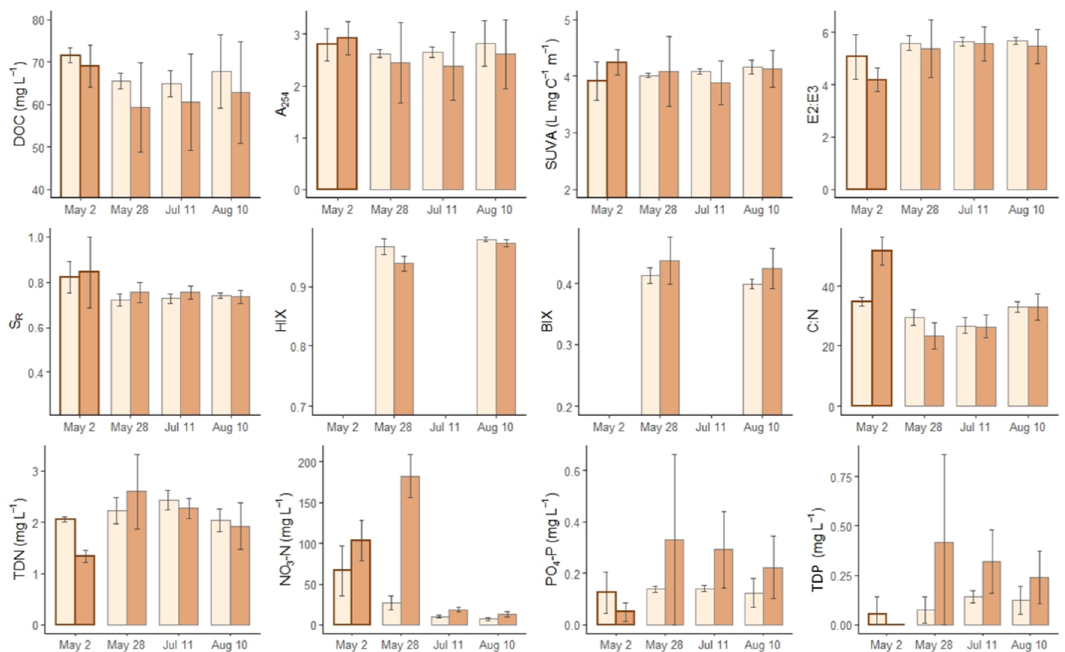
Figure 2. Concentration of dissolved organic carbon (DOC), nutrients, and dissolved organic matter (DOM) spectral parameters in the burned and unburned sections between 2 May and 10 August 2019. Columns show averages for three wells within each section, error bars represent standard deviation. The sampling event prior to the prescribed burn is highlighted with a brown outline.